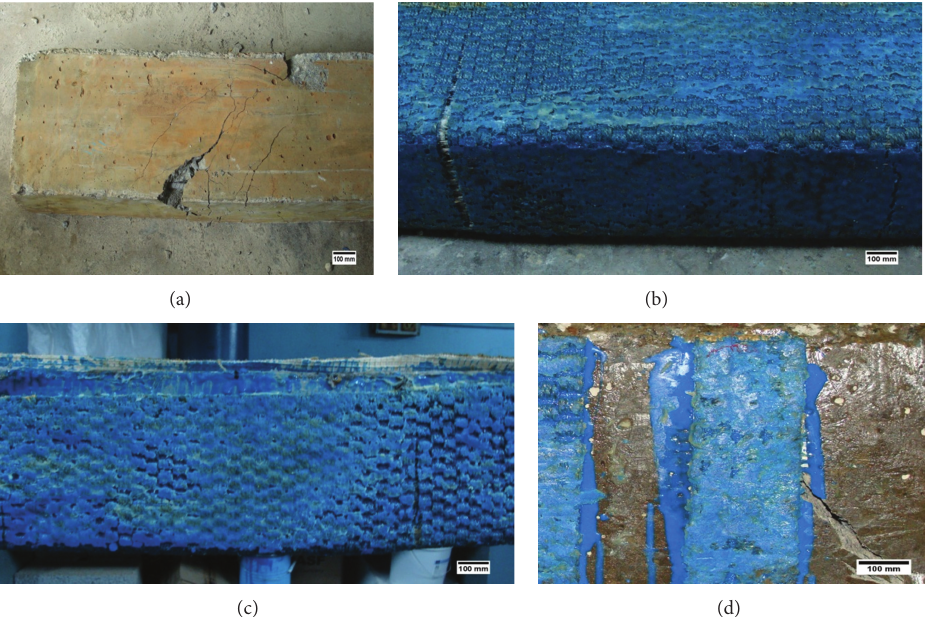
Figure 8: (a) fracture crack of beam ConS1; (b) fracture crack in the left and right shear zone of beam SS1; (c) fracture crack in the left and right shear zone of beam SS2; (d) fracture crack in the shear zone, and no crack in FRP, in beam SS3.